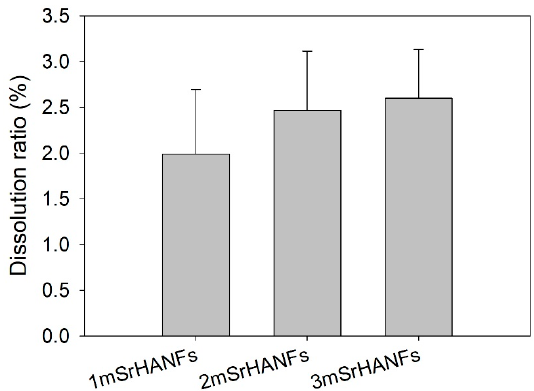
Figure 6. Degradation rate of the mesoporous strontium-substituted hydroxyapatite (mSrHANFs) after soaking in minimal essential medium (MEM) solution for 1 day. The data are presented as the averages ± standard derivations (n = 3).